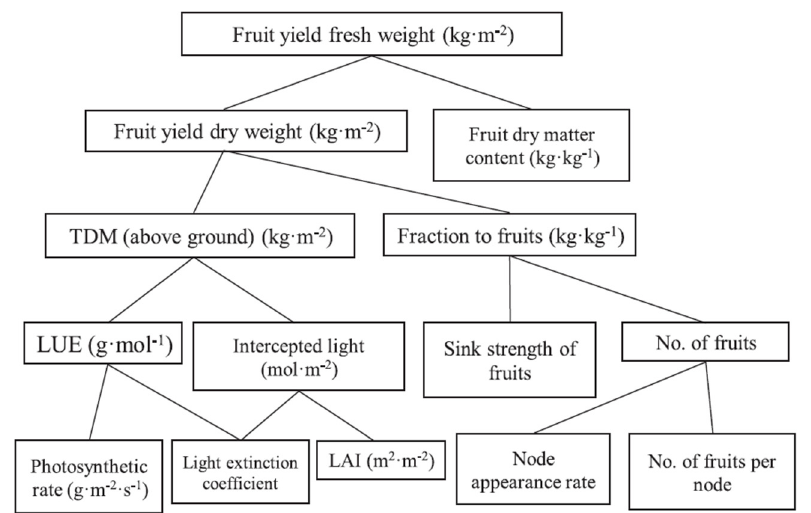
Figure 1. Components contributing to fresh fruit yield in cucumber cited by [17]: total dry matter production (TDM), light use efficiency (LUE), and leaf area index (LAI).